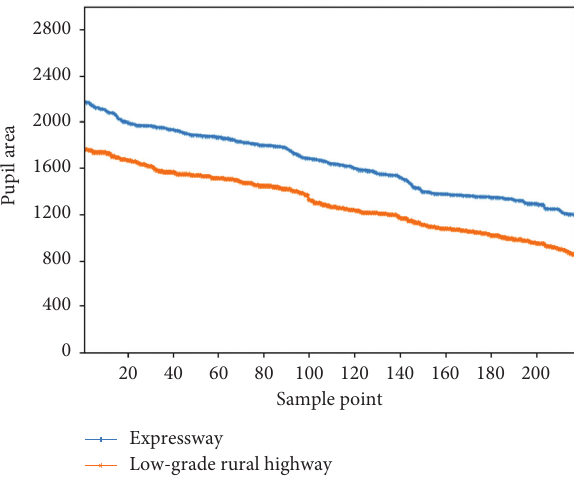
Figure 7: Mean pupil area of drivers.